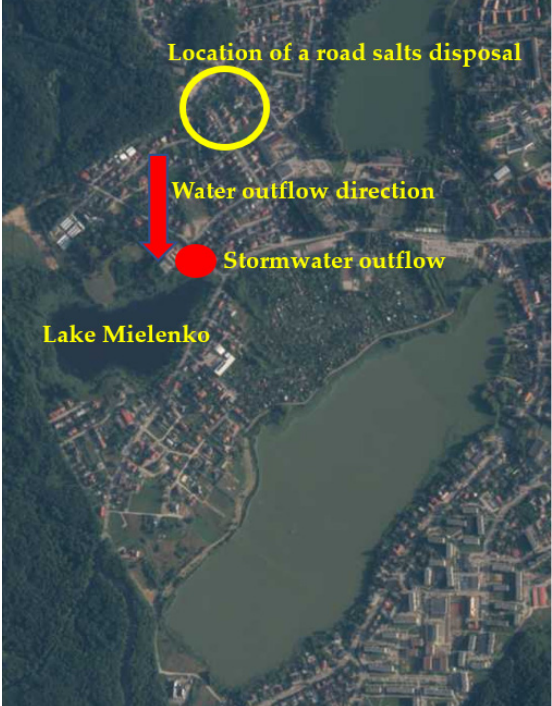
Figure 10. Location of a material repository for the elimination of slippery roads in the